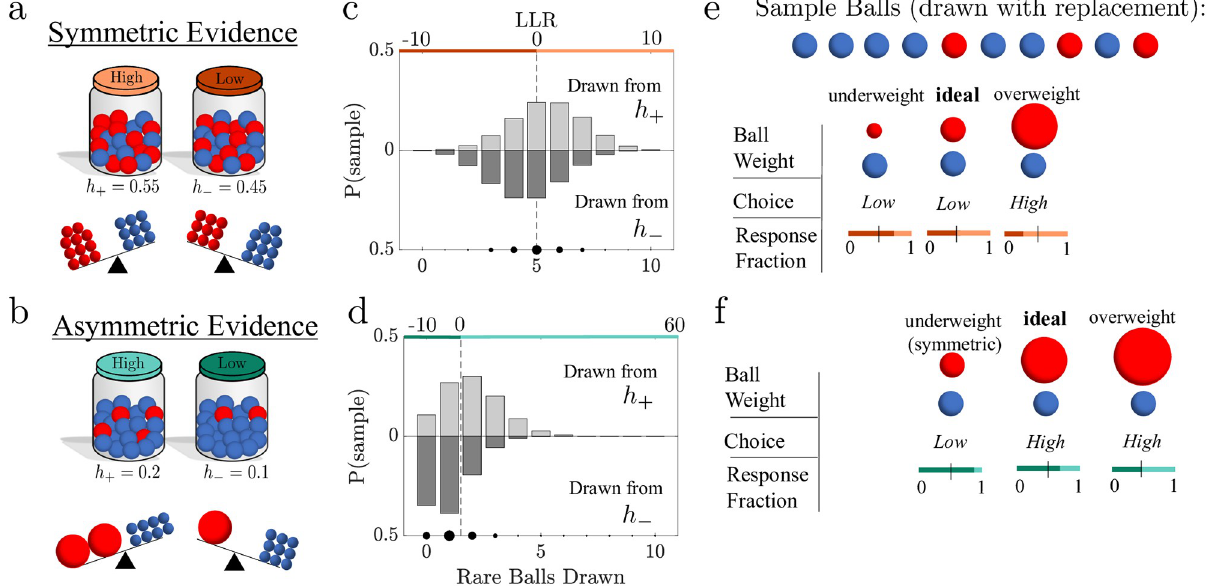
Fig 1. Different environmental evidence weights cause decision biases. a-b. Schematic of the Jar-Discrimination Task. Balls were drawn with replacement from one of two equally probable jars with different ratios of red to blue balls. Here h ± denotes the probability that a red ball is drawn from the high ( h + ) and low ( h ) jar. We consider conditions with symmetric priors and symmetric evidence ( h = 1 − h + ; a ), in which the red/blue ball − − observations had equal weights but opposite signs, or asymmetric evidence ( h − 6¼ 1 − h + ; b ), in which rare (in this example red) balls were weighted more heavily in a decision. c-d. The corresponding probability distribution of a 10-ball sample for a given number of rare balls drawn from the high jar ( h + , top) and low jar ( h − , bottom) for the symmetric ( c ) and asymmetric ( d ) evidence cases. Colored bars presented on the top axis denote an ideal Bayesian observer’s jar choice resulting from the associated log likelihood ratio (LLR; an LLR of zero results in a random response). e-f . Example of a 10-ball sample and corresponding choices of a Bayesian observer with varying relative ball weights. e. Ideal ball weights for the symmetric environment produce even response fractions. f. Ideal asymmetric weights produce a choice asymmetry in favor of the low jar. Deviations from the ideal weights in either environment produce decision